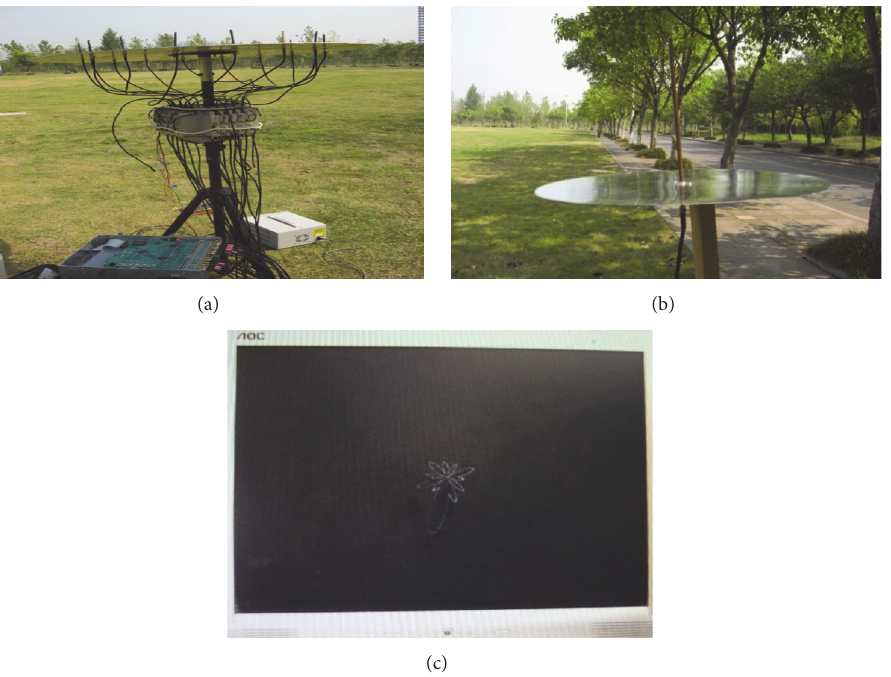
Figure 11: Experiment results. (a) Verification platform. (b) The beacon. (c) The formed